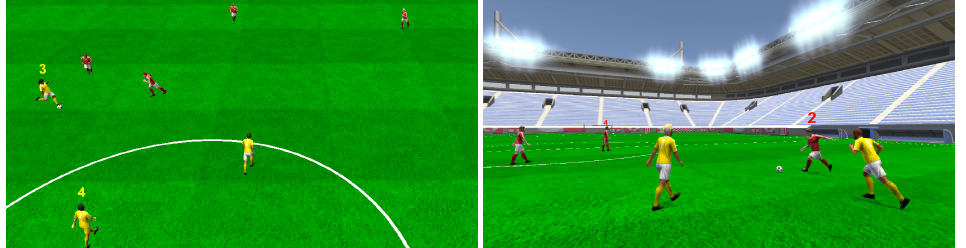
Figure 2. The left image shows an overview of an example soccer play, which was created using real-world tracking data. The right image depicts another example of a play within VR from the perspective of the user. The numbers above the virtual soccer agents’ heads represent the stimuli used for the recognition and recall task to be performed. Note that for the recall task, jersey colors were